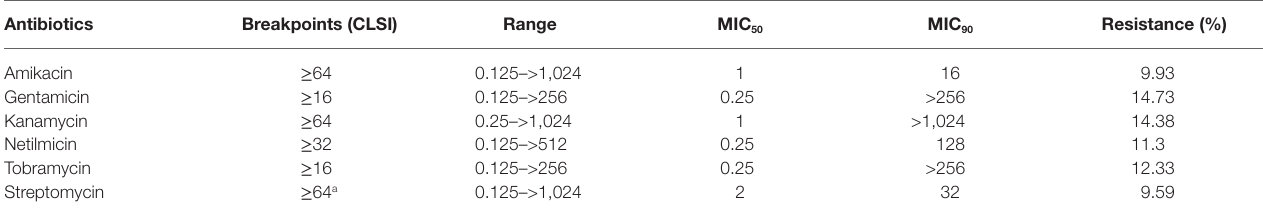
TABLE 1 | In vitro susceptibility to six aminoglycoside antibiotics for 292 isolates of the Klebsiella pneumoniae complex